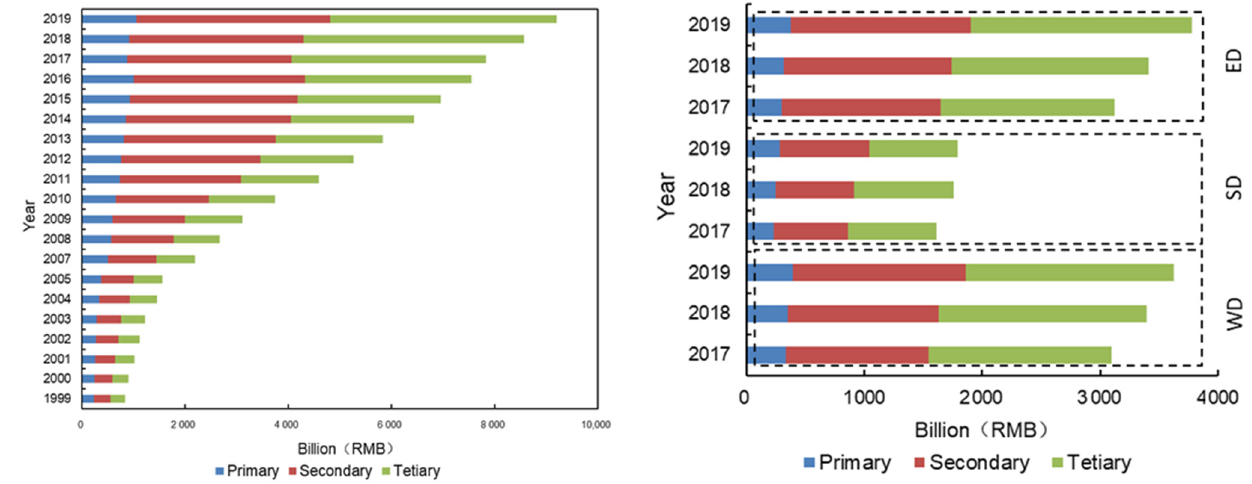
Figure 6. Economic development trend of Dongting Lake ( left ) and industrial structure composition in different areas of Dongting Lake during 2017–2019 ( right ). The primary output is agriculture, the secondary output is industry, and the tertiary output is service industry; WD: Western Dongting Lake; SD: Southern Dongting Lake; ED: Eastern Dongting Lake.